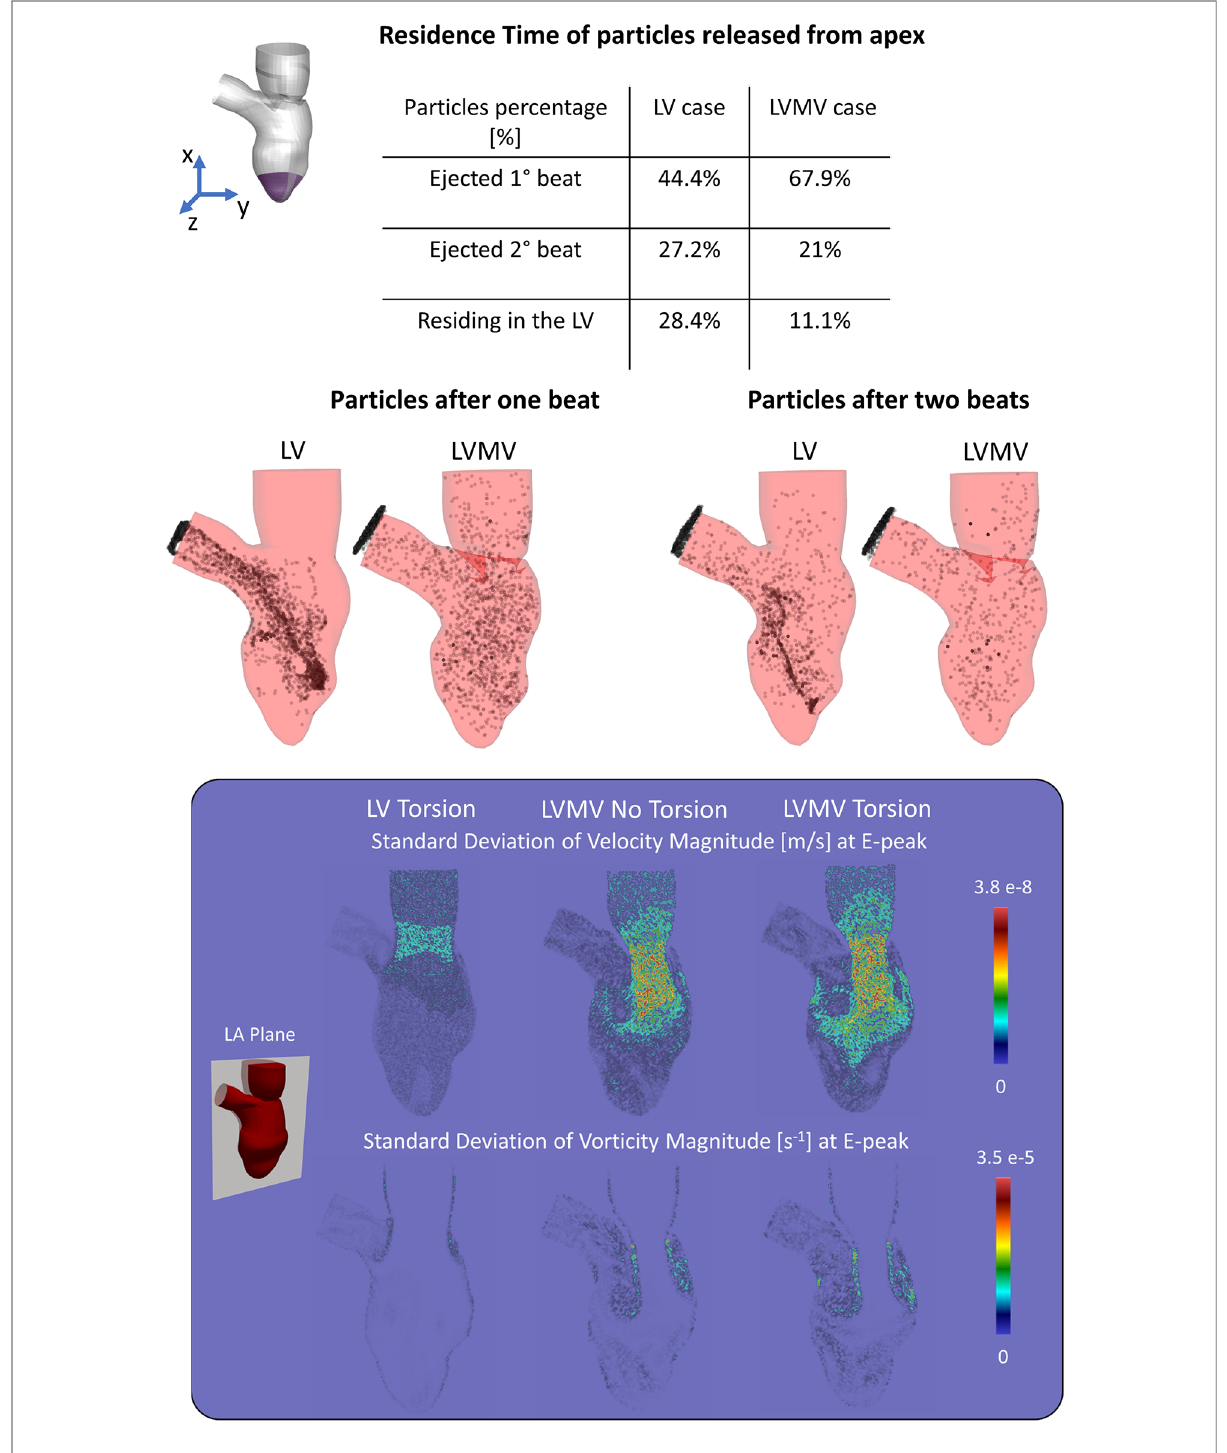
FIGURE 6 (Top) Residence time of the particles released from the apex show how the mitral valve enhances the apical wash-out. (Bottom) Standard deviation of velocity and vorticity magnitude in the LA plane between the 3rd, 4th, 5th, 6th cycle at the E-peak computed for the case with torsion and without MV (LV Torsion), the case without torsion and with MV (LVMV No Torsion), and the case with torsion and MV (LVMV